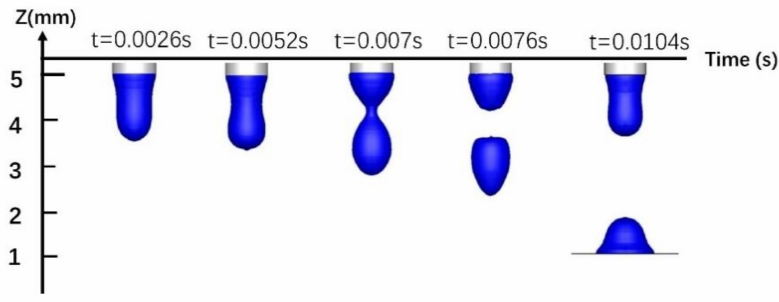
Figure 12. Single-MIG welding droplet transition.